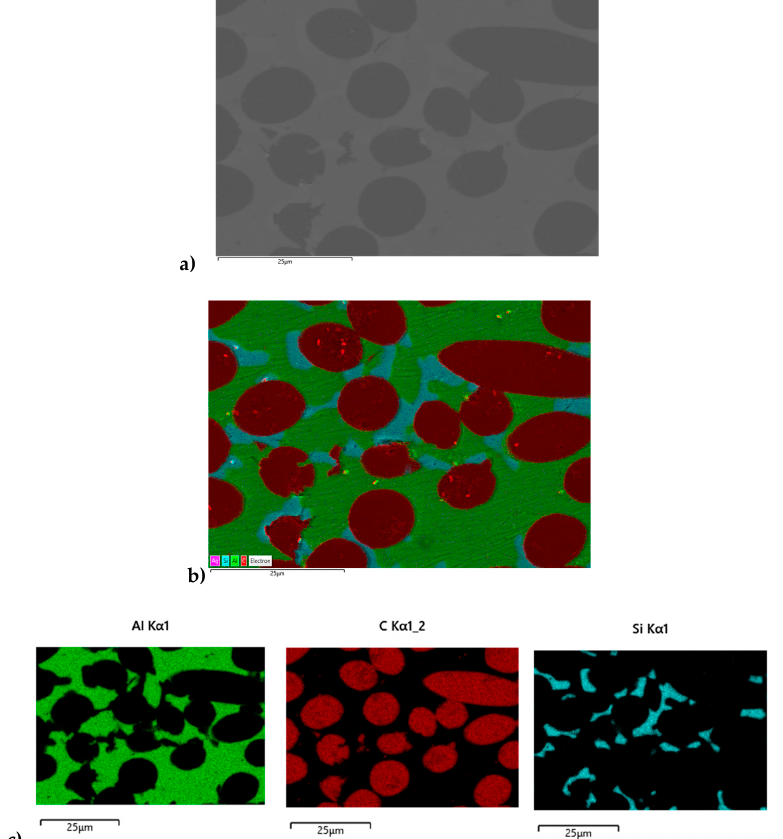
Figure 10. ( a ) SEM observation of a transverse cross-sectional cut of the GPI sample subjected to the same temperature and humidity cycle as the PM sample illustrated in Figures 8,9. No signs of internal corrosion are apparent. A continuous interface bonding between the C f s and the matrix is observed. ( b , c ) EDS mapping of the phases showing, in addition to the C-fibres, an Al-rich and a Si-rich phase in the AlSi eutectic alloy matrix.